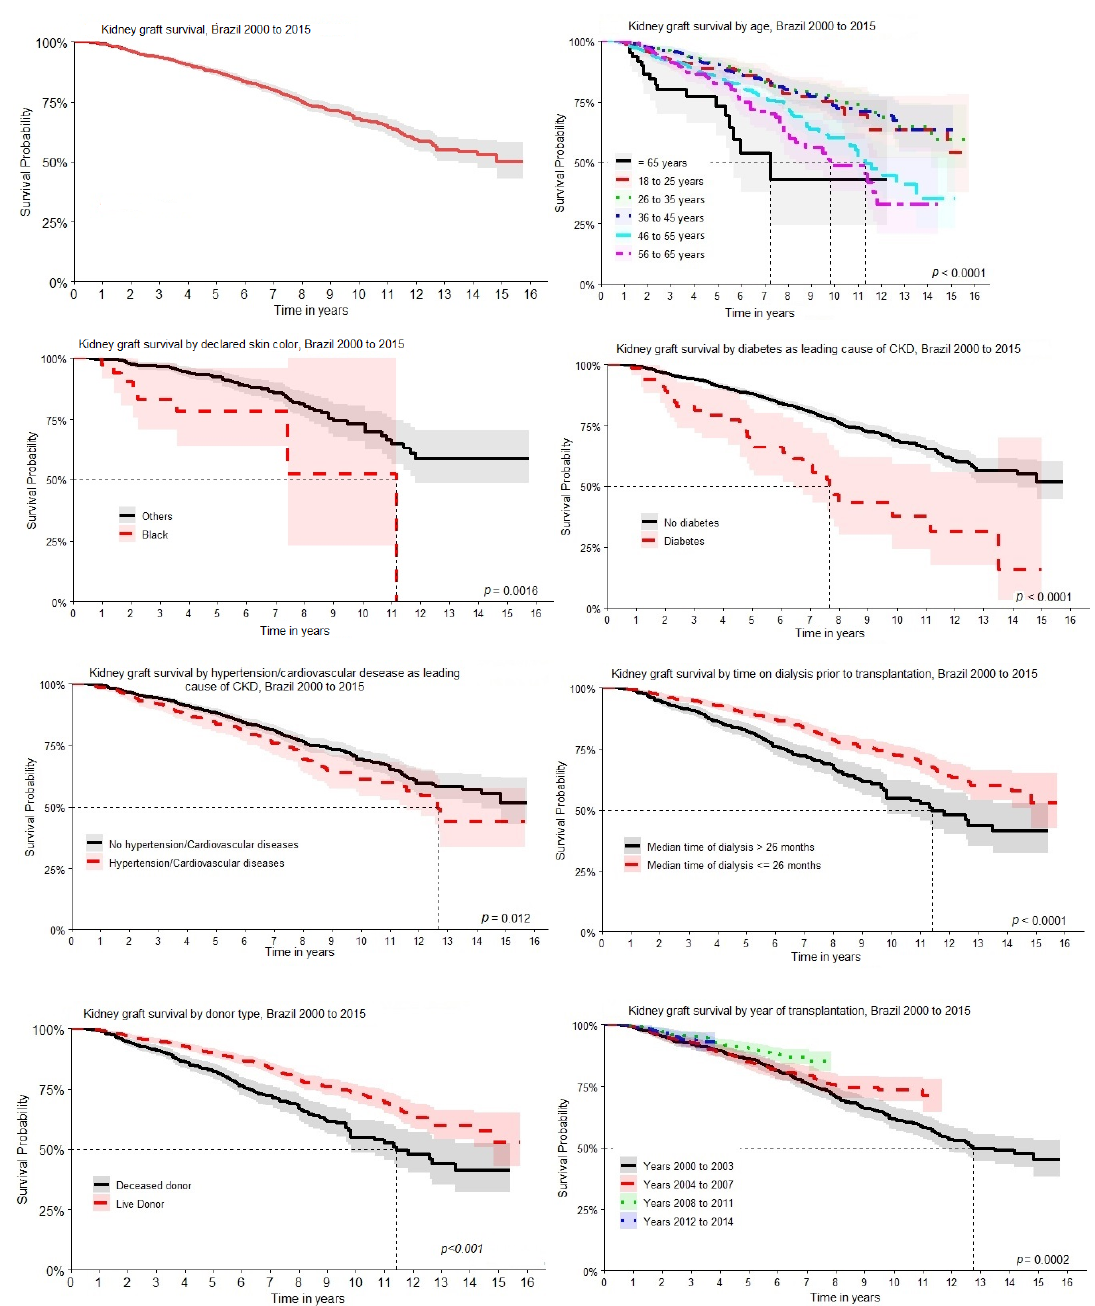
Figure 2. Kaplan–Meier graft survival estimates for 15 years after renal transplantation according to age of recipient, patient skin race/color, chronic kidney disease (CKD) primary diagnosis, donor type, dialysis length of time before transplant, and year of transplantation,